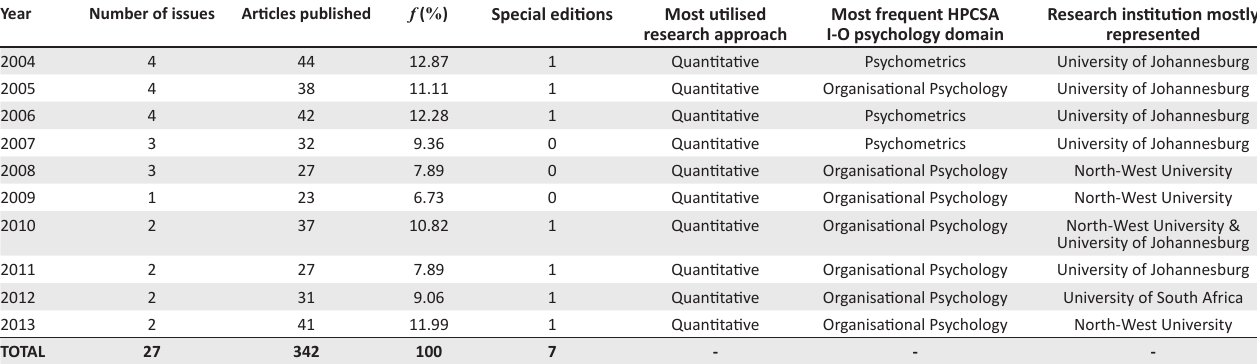
TABLE 1: General overview of SAJIP publications